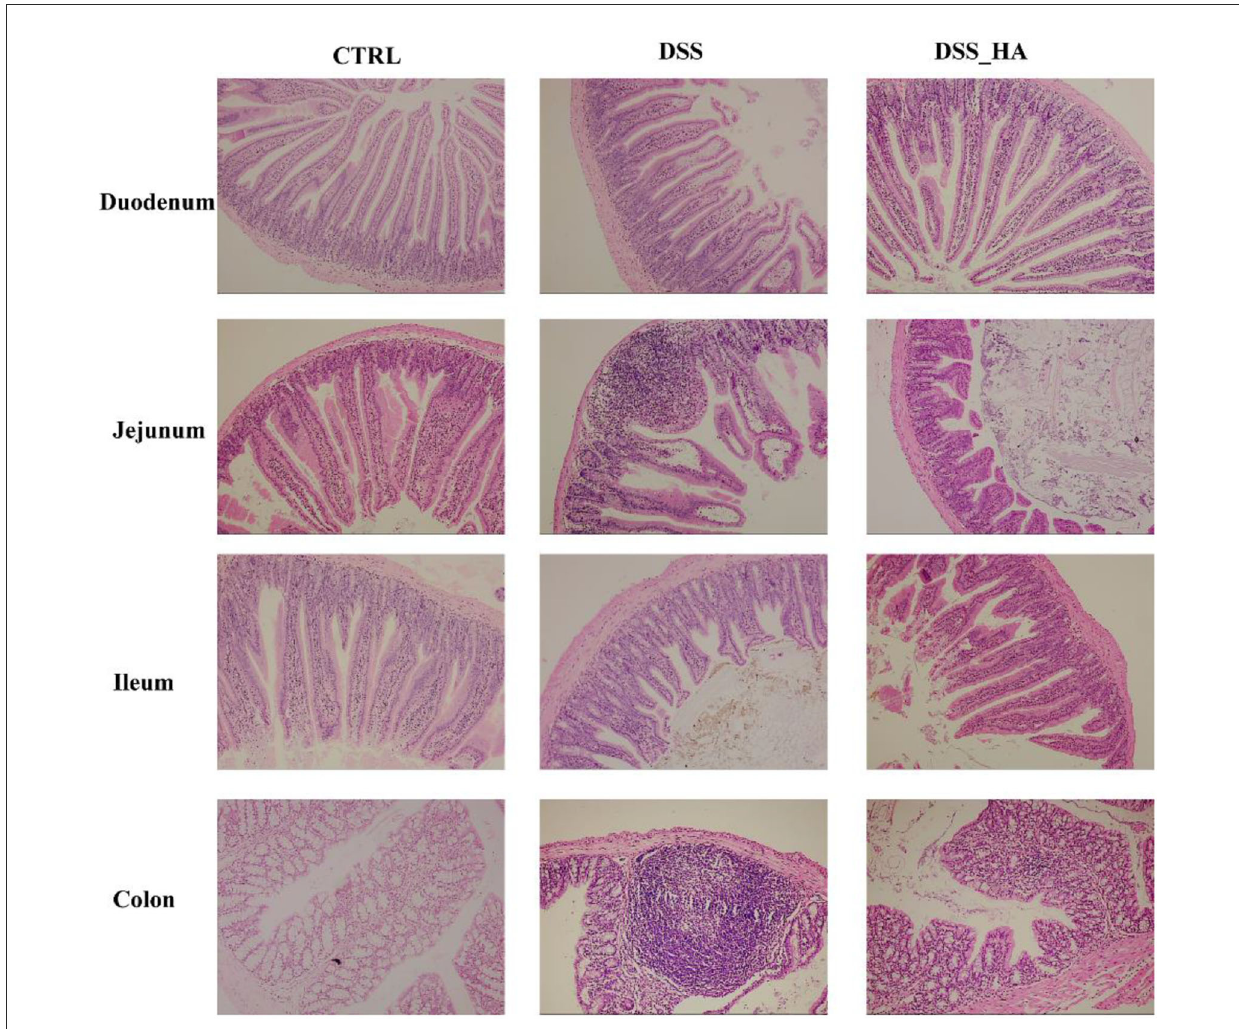
FIGURE2 Hematoxylin and eosin staining of the duodenum, jejunum, ileum, and colon in the CTRL, DSS, and DSS_HA